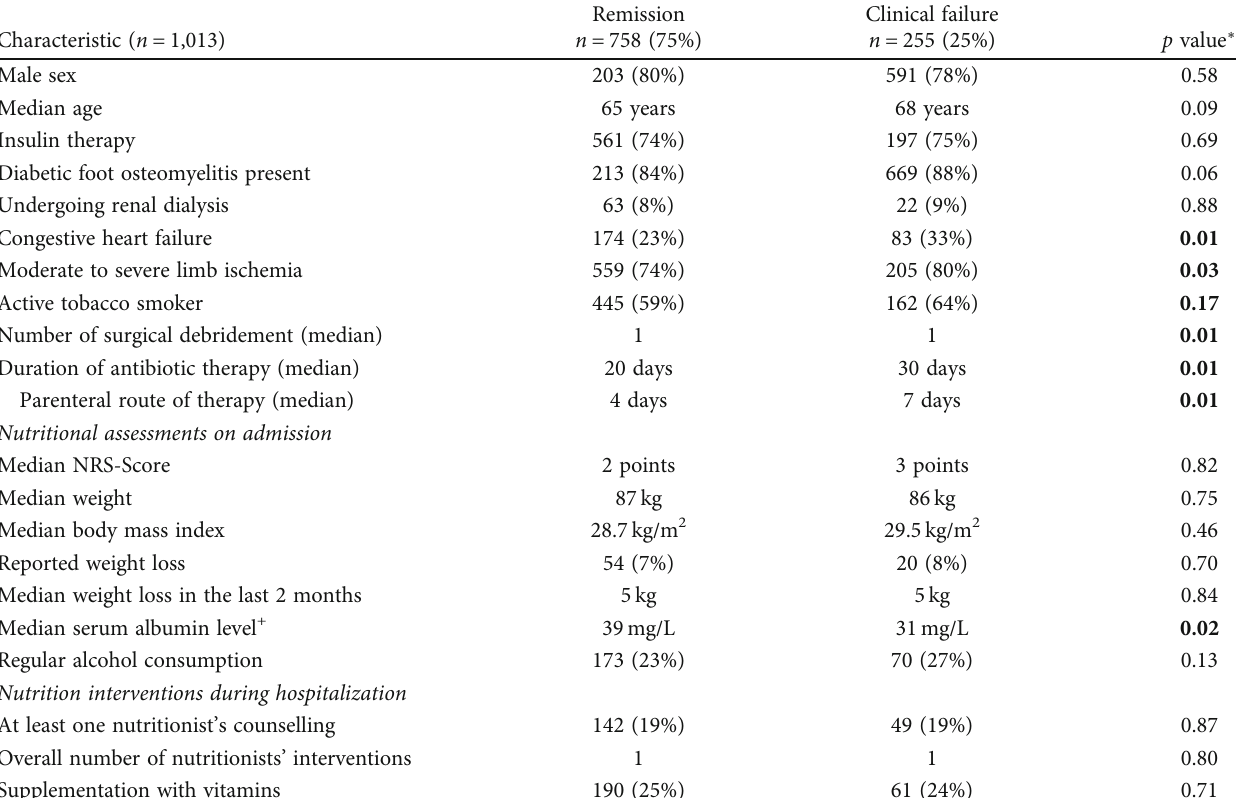
Table 1: Characteristics of 1,013 patients operated on for diabetic foot